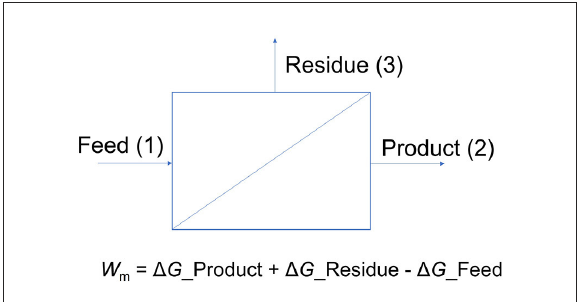
FIGURE1 Calculation of the minimum theoretical separation energy.